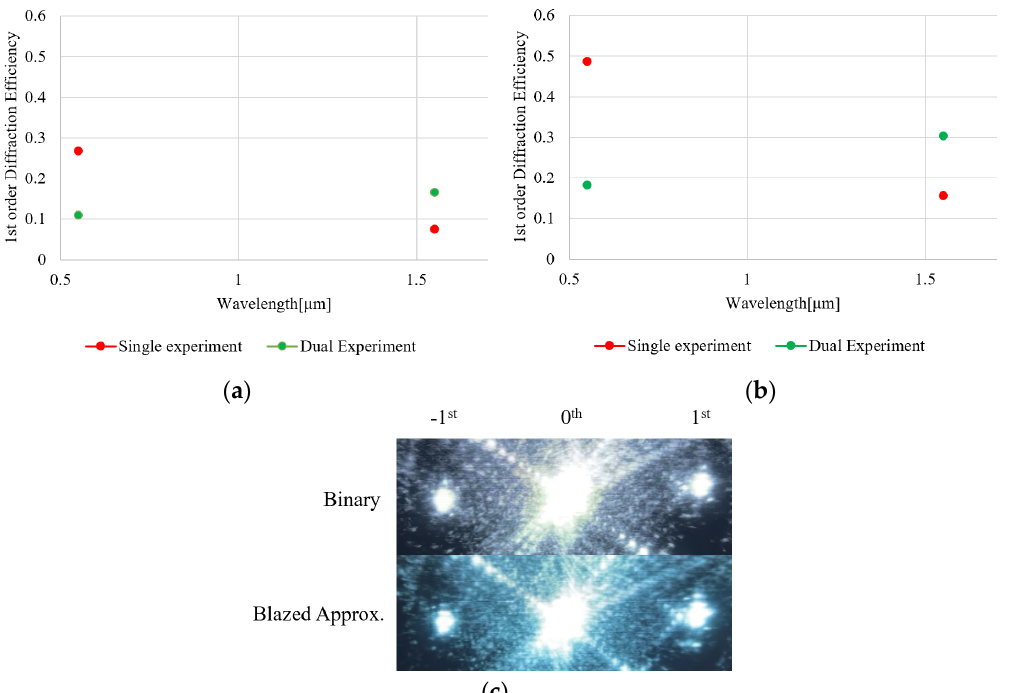
Figure 3. A +1st order diffraction efficiency for 4 pixels/period with ( a ) binary- and ( b ) staircase- approximated blazed grating profiles; ( c ) direct image for grating period of 4 dual modulation for binary and staircase, approximated by IR camera (C274103, Hamamatsu, Hamamatsu, Japan).